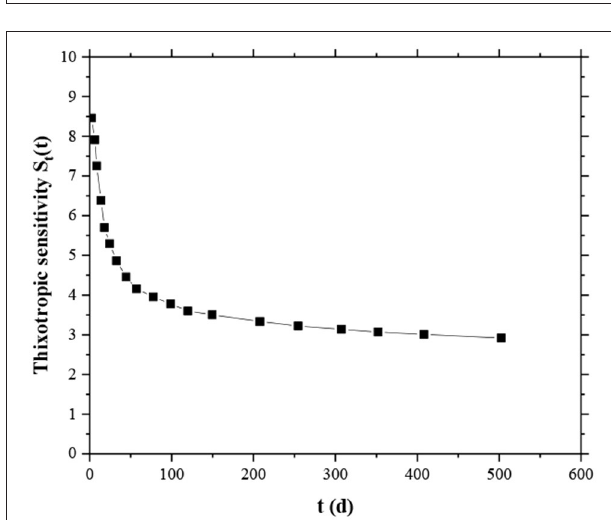
The shape of the S t ( t ) − t relationship curve may vary with different clays. The steeper the curve, the more obvious